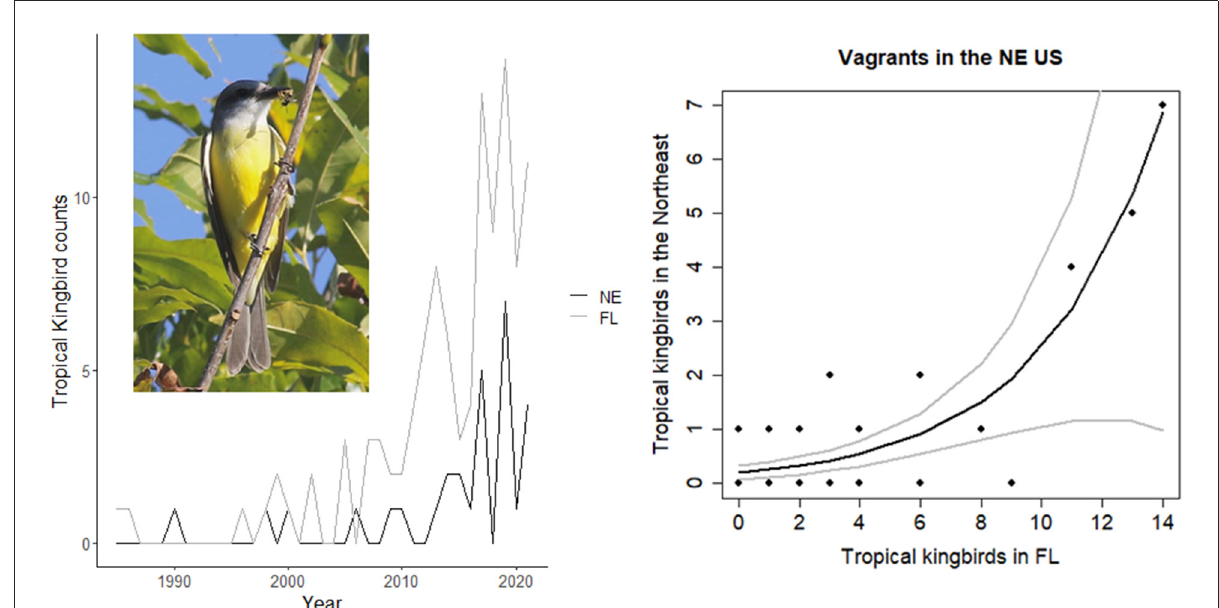
FIGURE1 (A) (Left) Numbers of vagrant Tropical Kingbirds ( Tyrannus melancholicus ) recorded in Florida (gray line) and the northeastern North America (bold line) 1980-present. (B) (Right) Prediction of vagrant Tropical Kingbirds in the northeastern North America on the basis of population growth in Florida. This relationship supports the idea that vagrancy is driven by population growth. Data from Pranty et al. (2016) and eBird (2021); photo by Anthony